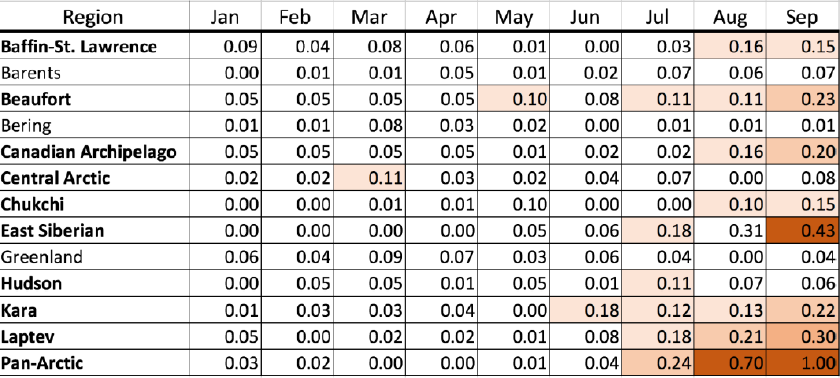
Table 2. Correlations between detrended monthly regional ice extent and detrended September pan-Arctic ice extent expressed as explained variance ( R 2 ). Cases in which at least 10% of the variance in September pan-Arctic ice extent is predictable by regional ice extent in a given antecedent month are highlighted with bold region names. Shading of boxes is as in Table